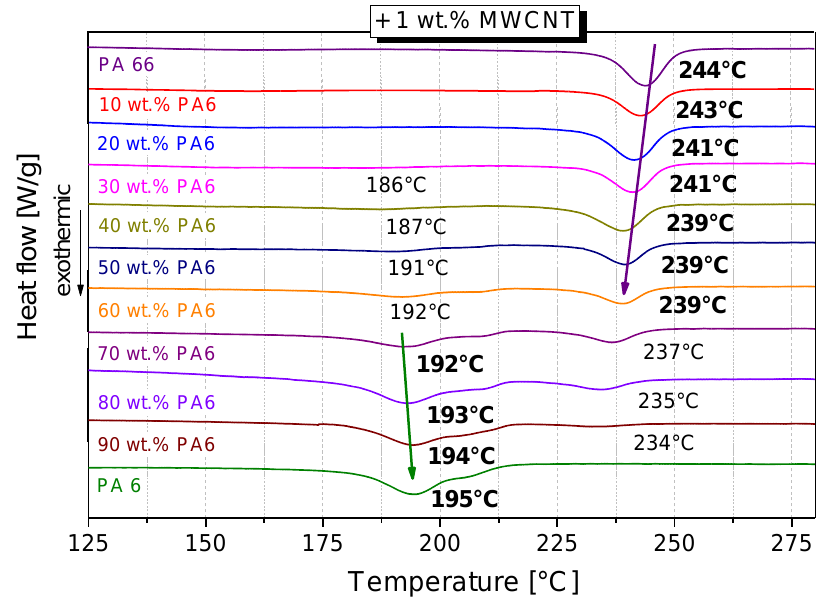
Figure 7. Crystallization behavior of PA6/PA66 blends filled with 1 wt % MWCNT, the values of maximum crystallization temperatures T c,max are given on the curves.